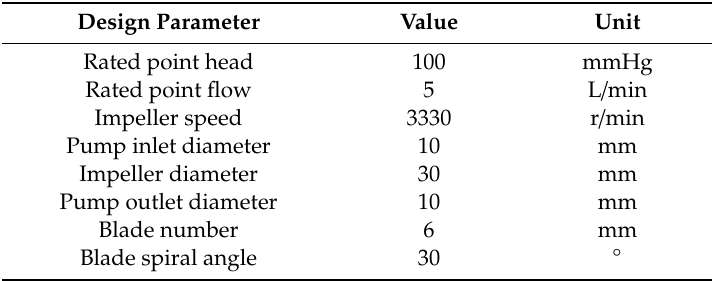
Figure 1. Pump geometry. ( a ) Photograph of the centrifugal blood pump; ( b ) geometric model of the blood pump. Table 1. Design parameters of the centrifugal blood pump.